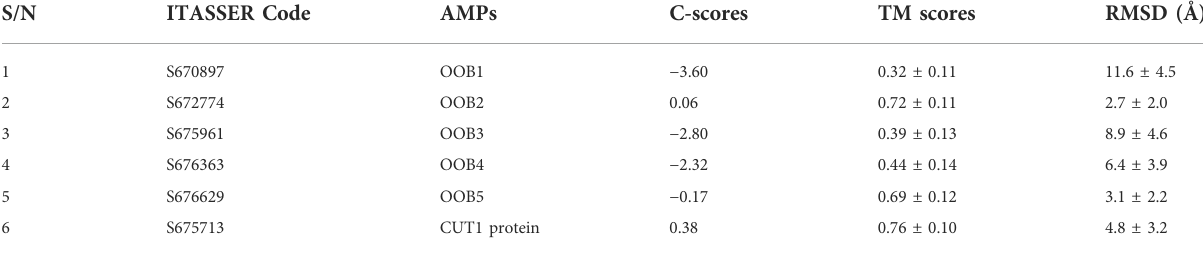
TABLE 7 Structure prediction of the anti- Fusarium solani AMPs and Fusarium solani CUT1 protein from I-TASSER.